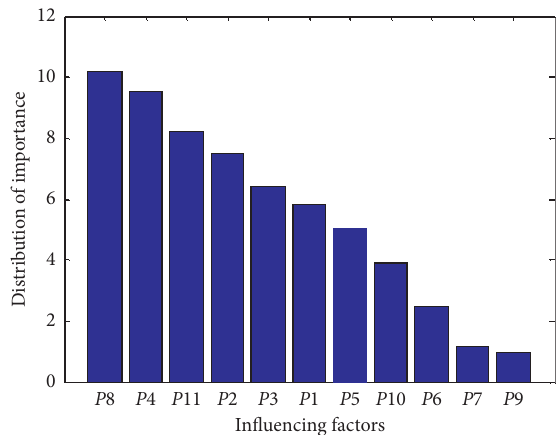
Figure 13: Importance distribution of influencing factors.